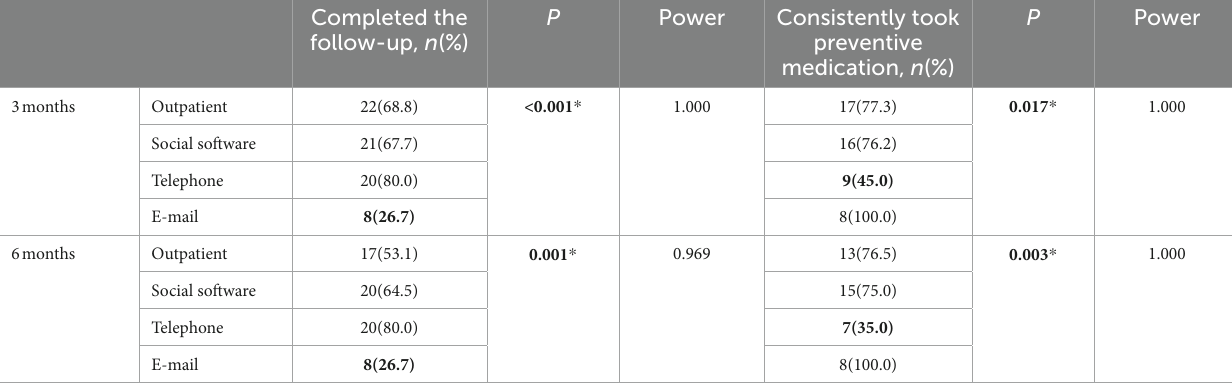
TABLE 5 Satisfaction of patients and specialists after 6 months in each group.